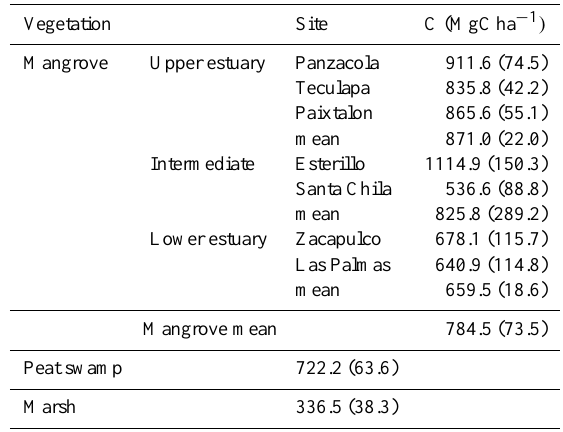
Table 6. Ecosystem C stocks (MgCha − 1 ) for wetlands of La En- crucijada Biosphere Reserve. Values are shown as mean (standard